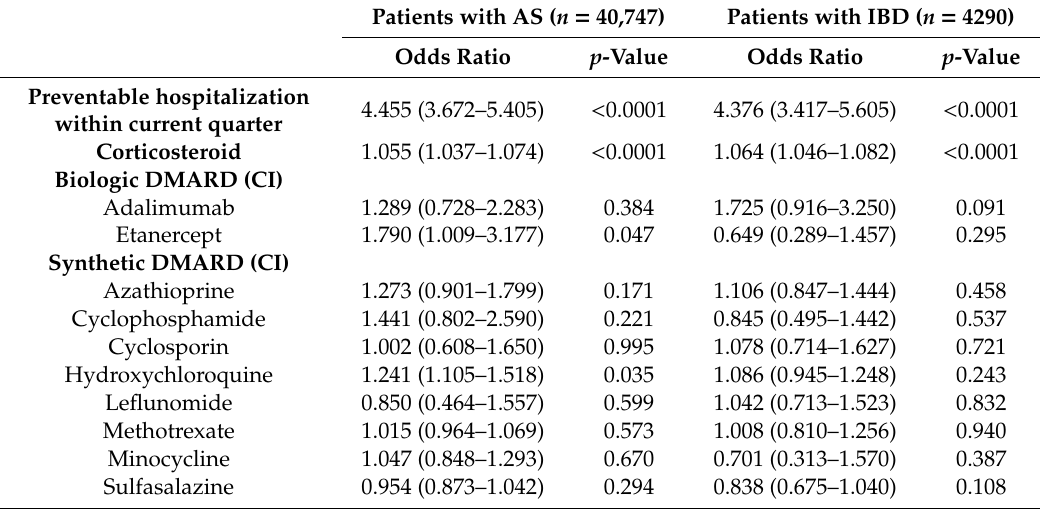
Table 4. Adjusted odds ratios of hospitalization by corticosteroid or disease modifying anti-rheumatic drug exposure by calendar quarter. Patients with AS ( n = 40,747) Patients with IBD ( n = 4290) Odds Ratio p -Value Odds Ratio p